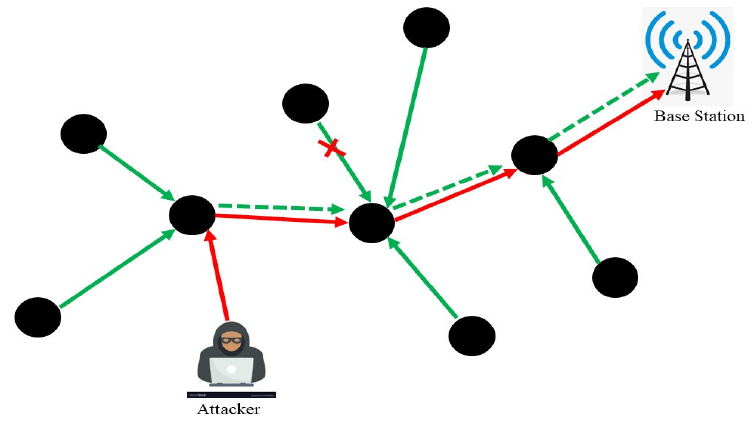
Figure 11. A path-based DoS Attack.